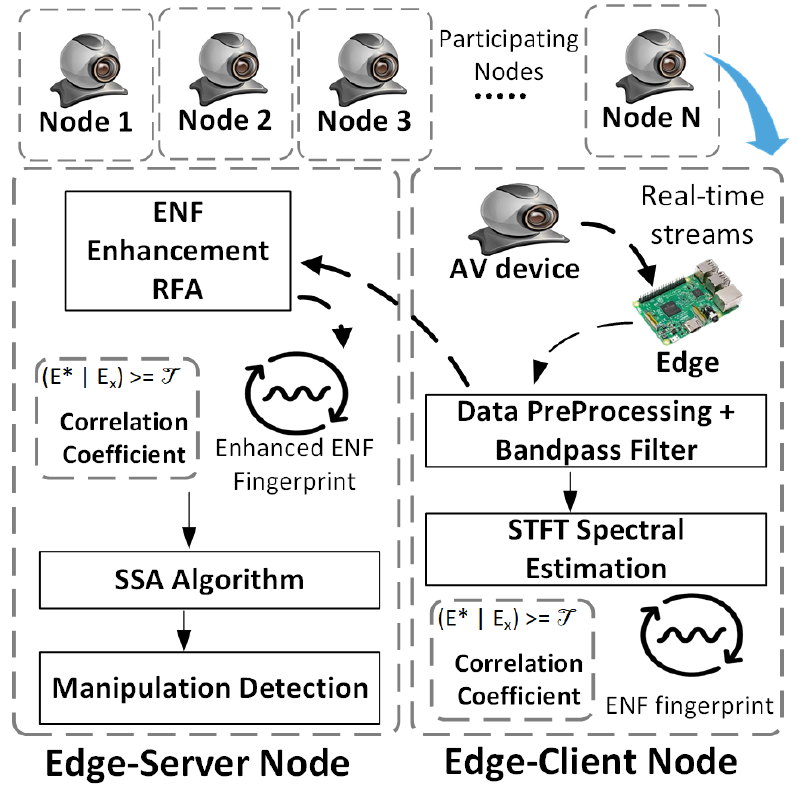
Figure 2. System architecture of deterring deepfake attacks at the edge